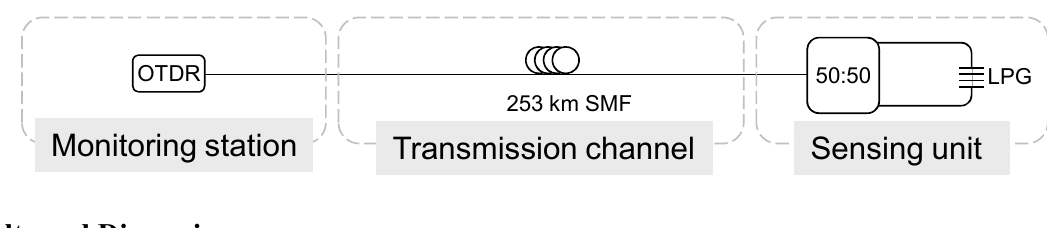
Figure 15. Experimental set-up for the LPG-FLM sensor system. Adapted from